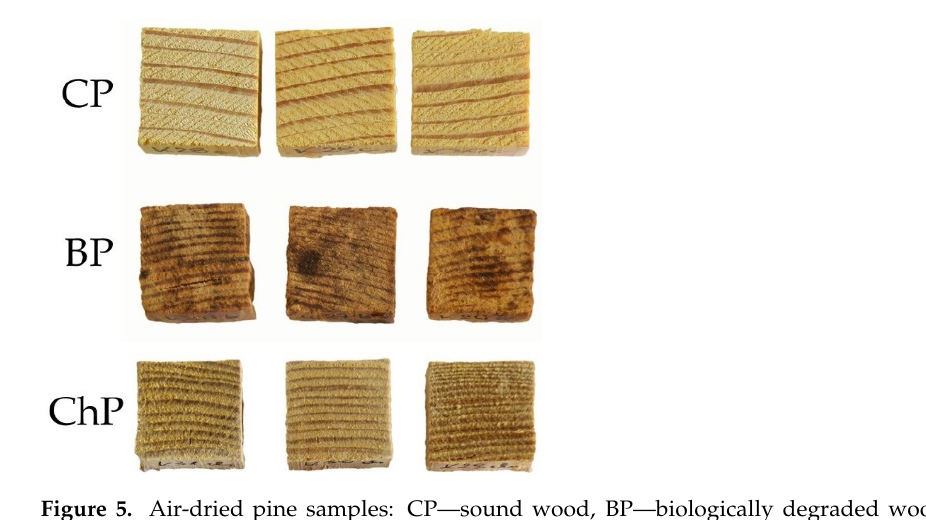
Figure 5. Air-dried pine samples: CP—sound wood, BP—biologically degraded wood, ChP—chemically degraded.